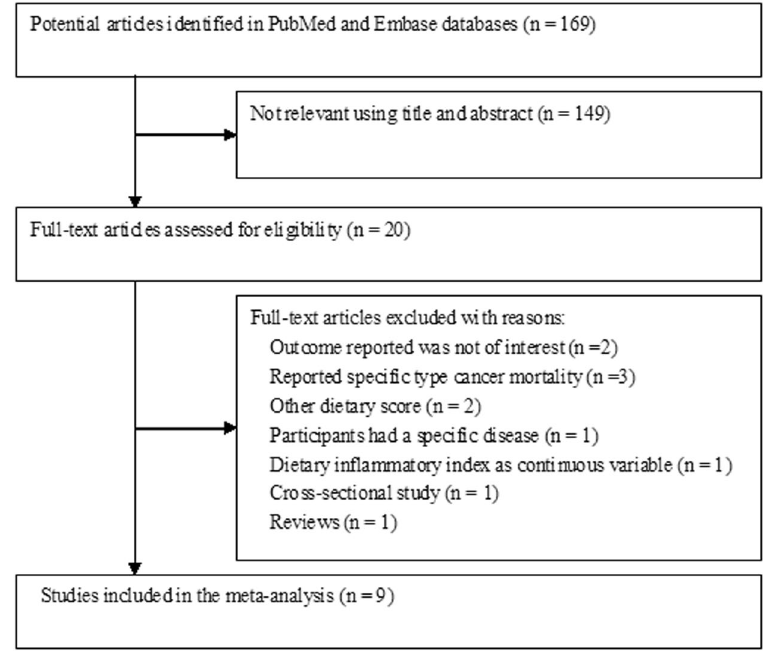
Figure 1. Flow chart of study selection